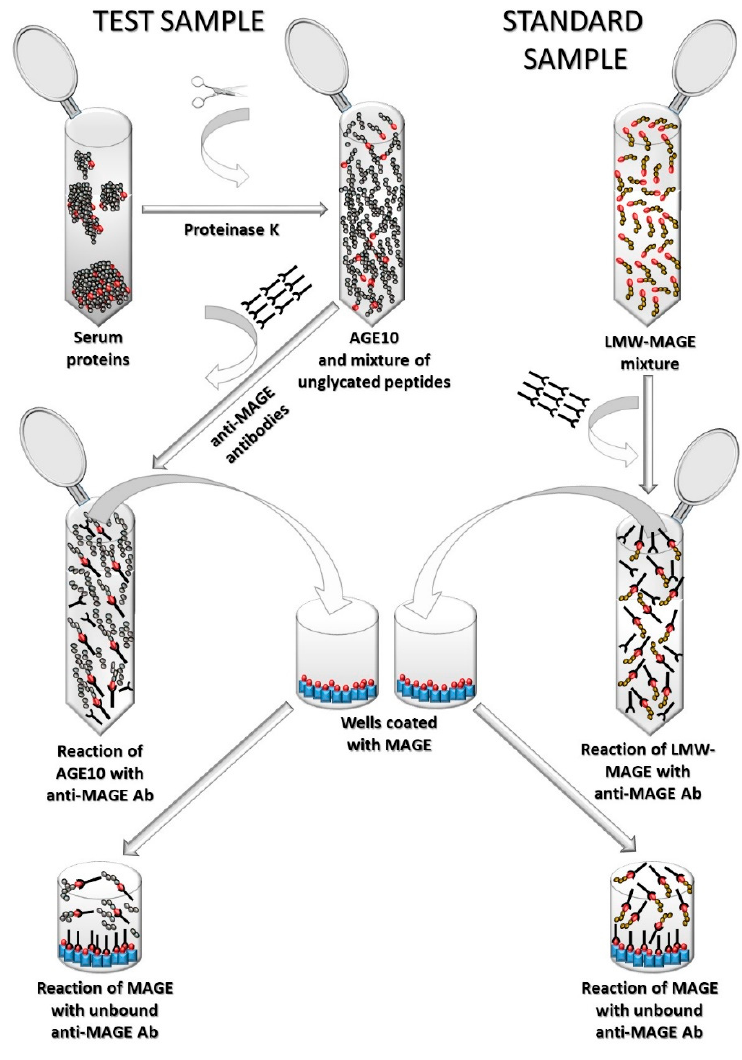
Figure 5. Scheme of AGE10 ELISA. Ab, antibodies; LMW-MAGE, low molecular mass advanced glycation end-products obtained by NAc α Lys modification with melibiose (analogue of AGE10 epitope) depicted as red circles; MAGE, advanced glycation end-products obtained by myoglobin modification by melibiose depicted as blue rectangles.